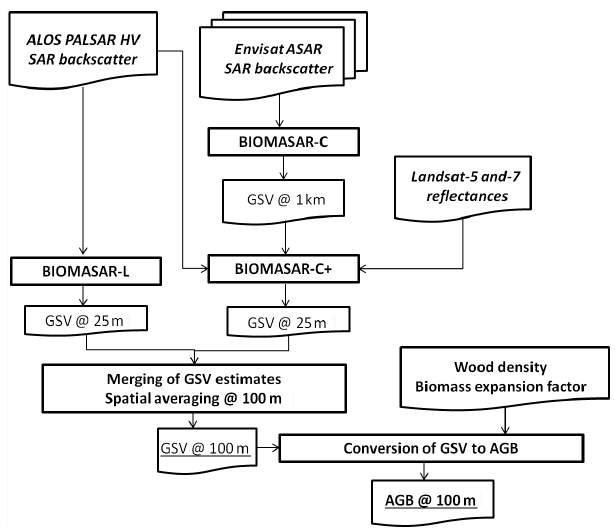
Figure 1. Flowchart of the AGB retrieval